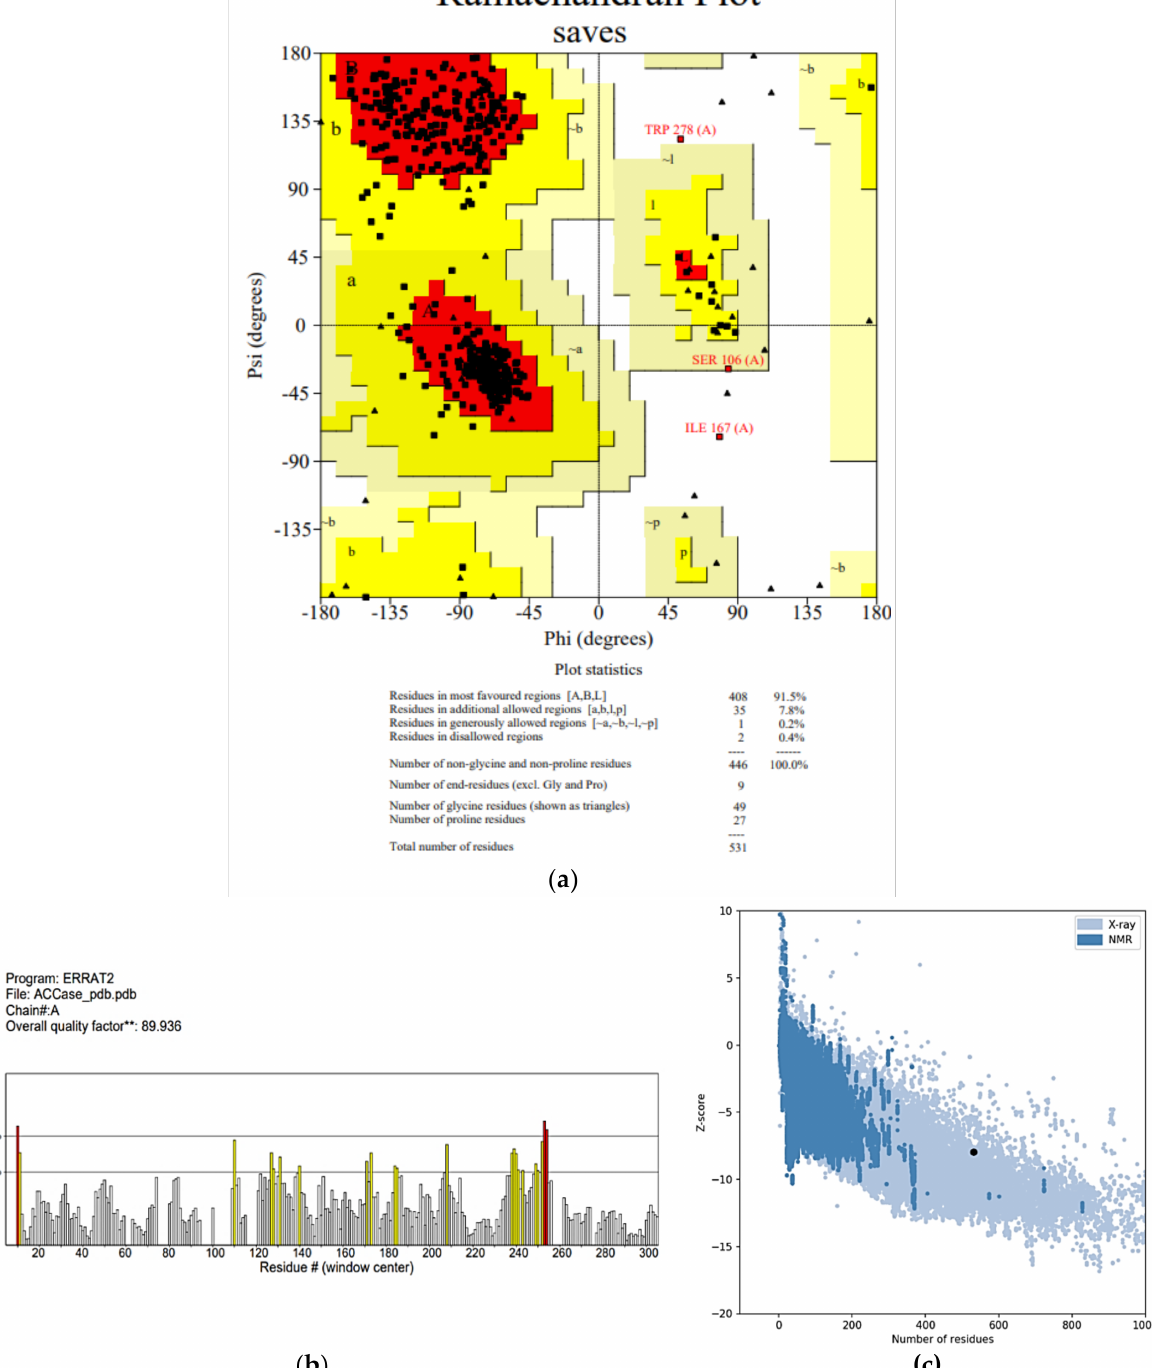
Figure 2. Validation of the homology structure of E. crus - galli. ( a ) Ramachandran plot represents the presence of amino acids (black) in most favored (red) and allowed regions (yellow); ( b ) ERRRAT plot analysis using SAVES tool. The plot calculates the OQF ** (% of protein) and the error value * (confidence level of structure) of protein structure; and ( c ) Z − score calculation using ProSA tool (black dot implies the range of score falls in X-ray